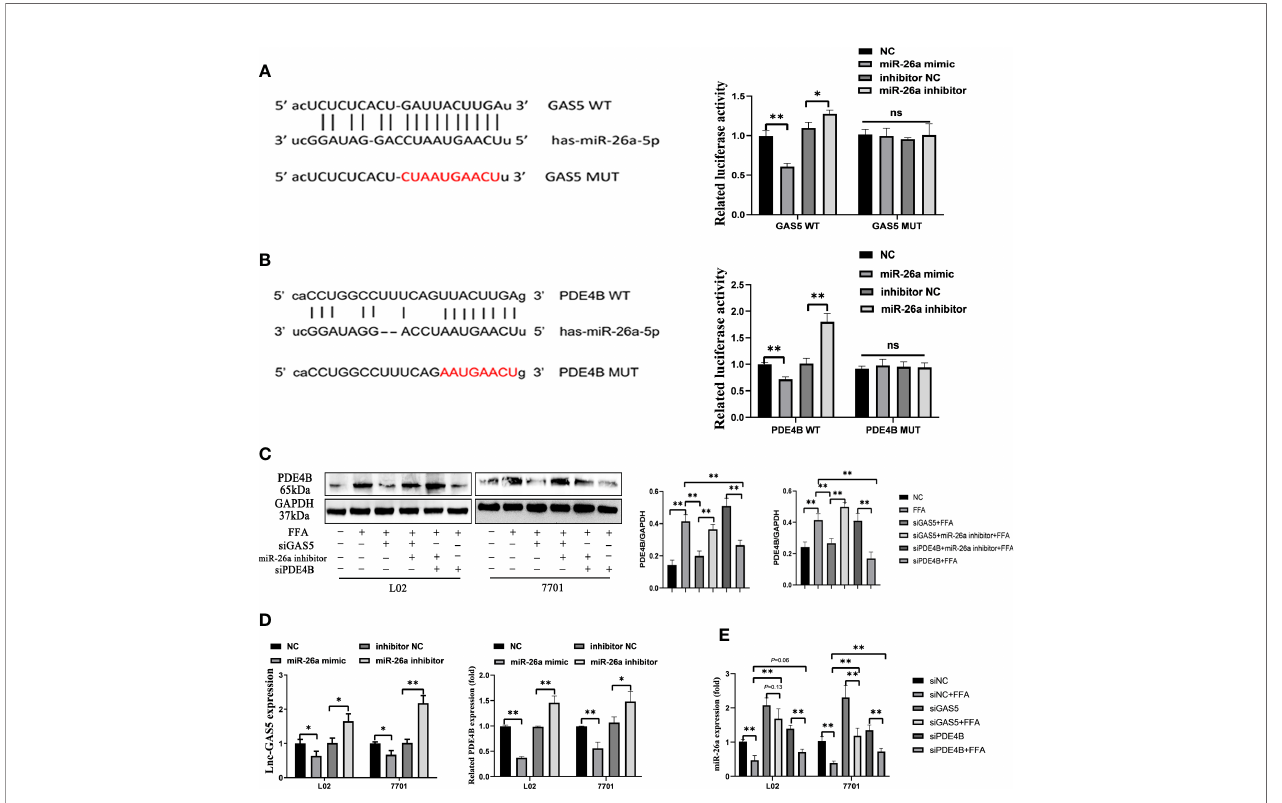
FIGURE 5 | Long non-coding RNA growth arrest speci fi c 5 (GAS5) regulates phosphodiesterase-4D (PDE4B) by sponging miR-26a-5p. Bioinformatic predictions of the miR-26a-5p targeting GAS5 3 ′ UTR through the binding sequence, and dual luciferase reporter detection of GAS5 and miR-26a-5p (A) . Bioinformatic predictions of the miR- 26a-5p targeting PDE4B 3 ′ UTR through the binding sequence, and dual luciferase reporter detection of PDE4B and miR-26a-5p (B) . The protein expression of PDE4B in different groups (C) . The expression of GAS5 and PDE4B of cells transfected with a miR-26a mimic or inhibitor (D) . The expression of miR-26a-5p in cells with GAS5 knockdown or PDE4B knockdown (E) . Data are expressed as mean ± standard error of mean. * P < 0.05 and ** P < 0.01, n = 3. ns, not signi fi ( Figure S6A ), and different pattern of lipid and lipid like metabolites were shown in Figure S6B . The 20 most enriched Kyoto Encyclopaedia of Genes and Genomes pathways based on metabolite variations are shown in Figure S6C . Given the close association between PDE4B and cAMP, the changes and roles of the cAMP pathway were analysed in this study ’ s models.